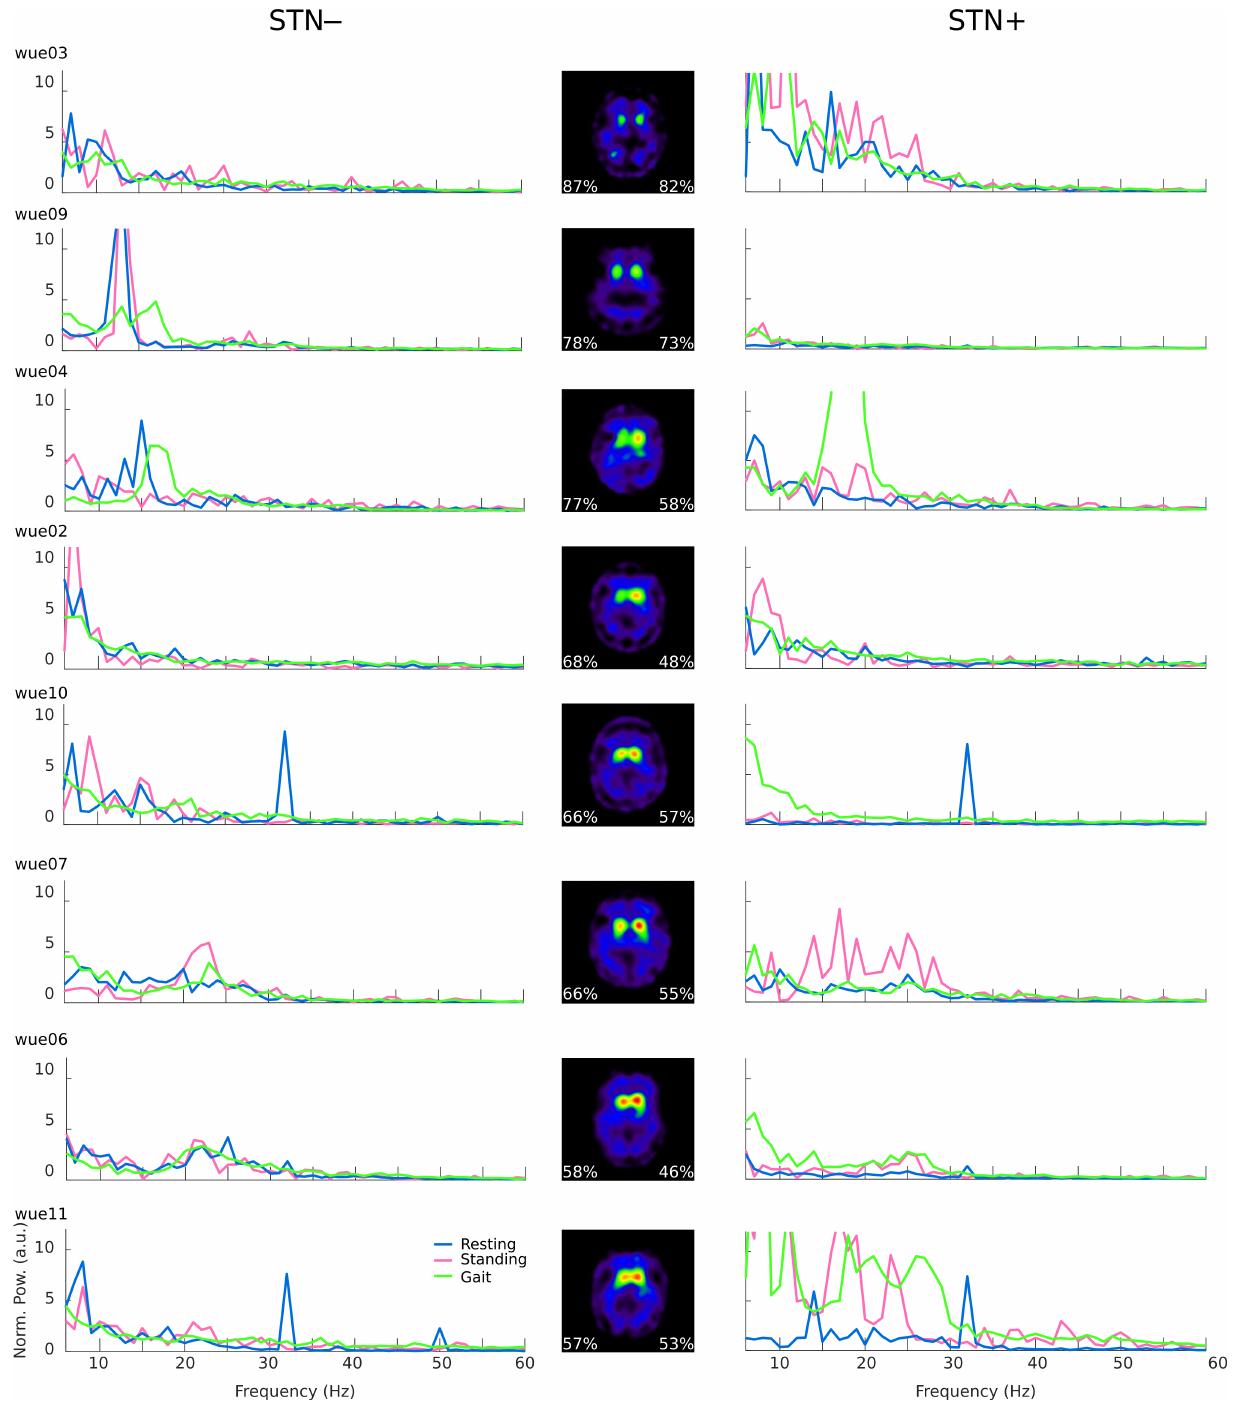
Fig 3. Spectral profiles (single subject) during resting, upright standing and gait. Single subject spectral power of the STN local field potential during resting (blue line), standing (pink line) and gait for the two hemispheres, with less (–) and more (+) striatal dopamine innervation. Axial slices are left- right flipped to match the corresponding STN. The peak at 32 Hz is a known artefact of the Activa PC+S 1 system tied to clock settings or due to a triggered check of the battery status. SPECT scans (central column) show striatal dopaminergic loss as percentage decline with respect to healthy subjects (calculated from BP ND of DAT, Table